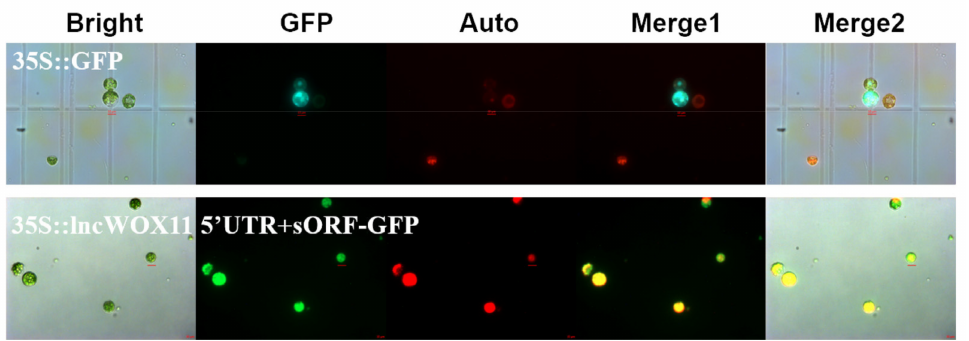
Figure 2. Verification of the coding ability of lncWOX11a . Protoplasts transiently expressing lnc- WOX11a were observed under a fluorescence microscope. Bright-field, green fluorescent pro- tein (GFP), chlorophyll autofluorescence (Auto), merged 1, and merged 2 images are shown. Scale bar = 10 µ m.